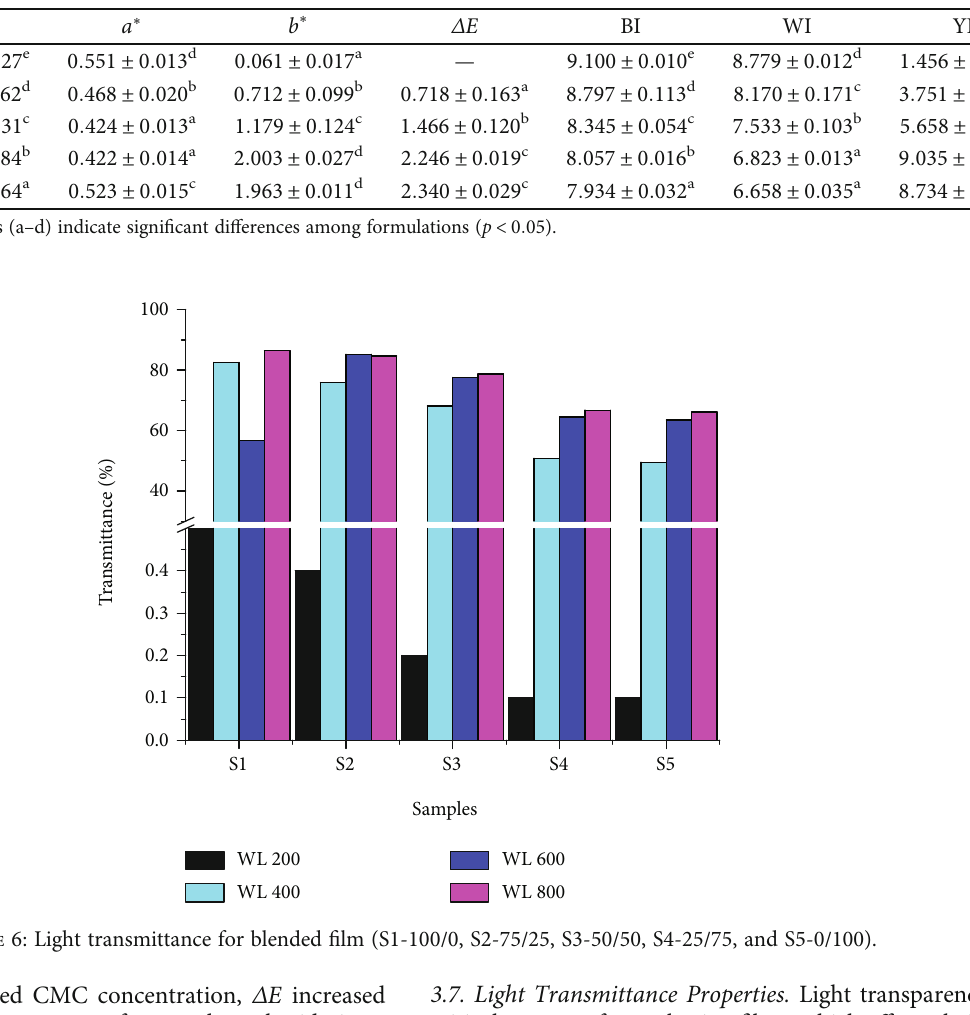
Table 2: Colour parameters of the blend fi lms.